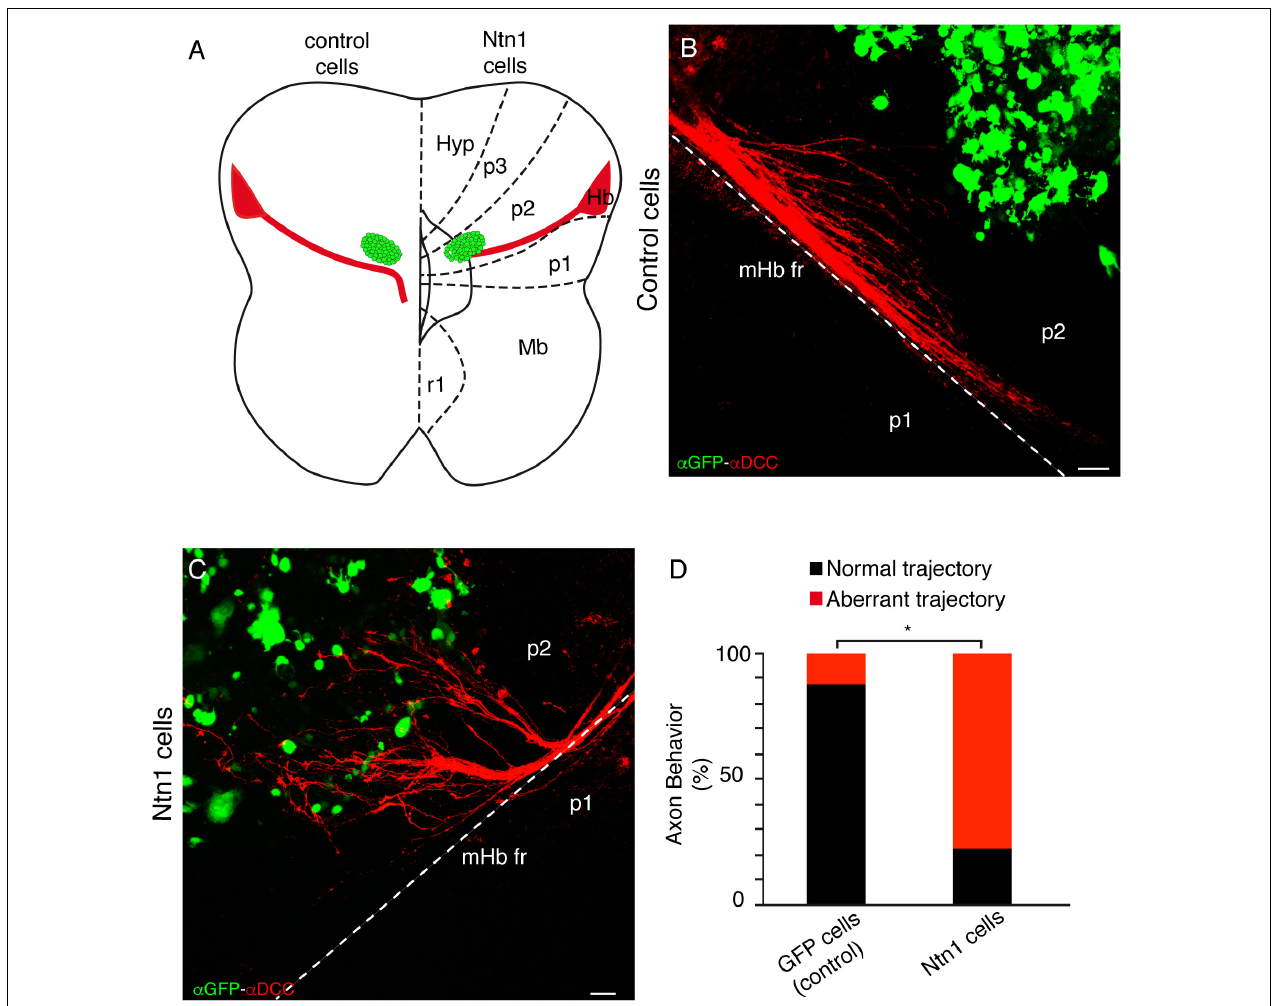
FIGURE 6 | Ectopic Ntn1 -expressing cells attract the mHb rostrally in ONTs. (A) Schematic representation of the transfected cells’ location in E12.5 ONTs. Basal and floor plates are delimited by continuous lines. The floor plate is on the left and caudal to the bottom. (B) Characterization of the control experiment with GFP transfected cells labeled against GFP and DCC; the fr axons maintained their normal trajectory. (C) Characterization of the experiment with Ntn1 -expressing cells labeled against GFP and DCC; the mHb axons are redirected toward the cells located in the rostral diencephalon. (D) Quantification indicating the percentage of experiments with a normal or modified trajectory mHb fr. * p < 0.01. Abbreviations: Hb, habenula; Hyp, hypothalamus; Mb, midbrain; p1, prosomere 1 (pretectum); p2, prosomere 2 (thalamus); p3, prosomere 3 (prethalamus); r1, rhombomere 1; fr, fasciculus retroflexus. Scale bar: 100 µ